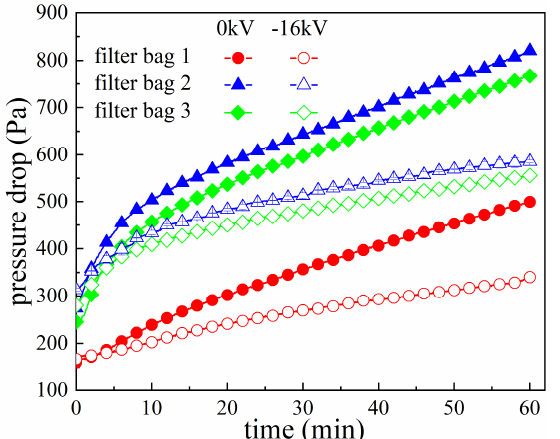
Figure 7. Variation in pressure drop for dust collectors with different filter bags.